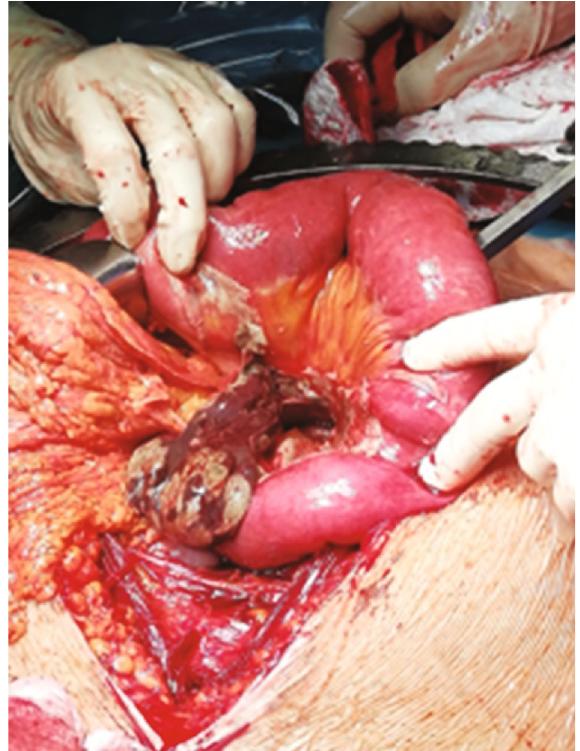
Figure 1: Distended and necrotic Meckel ’ s diverticulum.